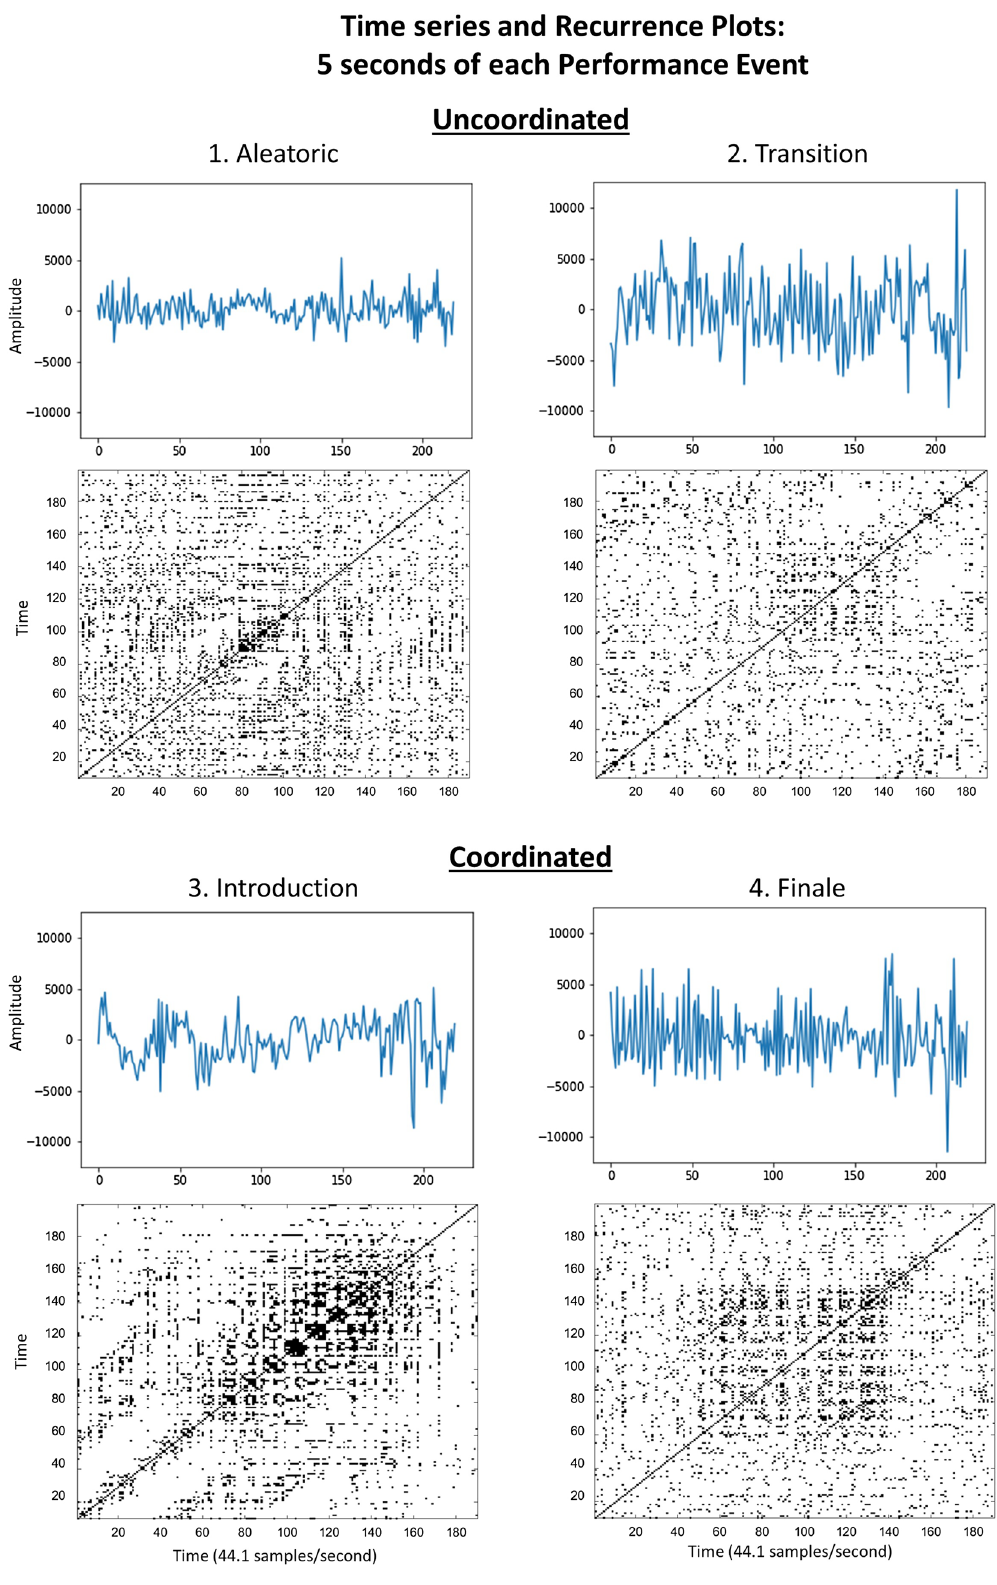
Figure 2. Time series and recurrence Plots for representative 5-s samples drawn from each 30-s sample in Fig. 1, and labeled as the associated Performance Event the 5-s sample is drawn from. Uncoordinated Aleatoric and Transition plots more closely resemble white noise, with fewer recurrent points, shorter diagonals, and less apparent vertical structures. Increased presence of diagonal lines and vertical structures in Coordinated Introduction and Finale plots indicate increasingly coordinated interaction among the musicians. Note: 9 s of audience applause during the Introduction Performance Event were not analyzed, and are subsequently excluded from all data